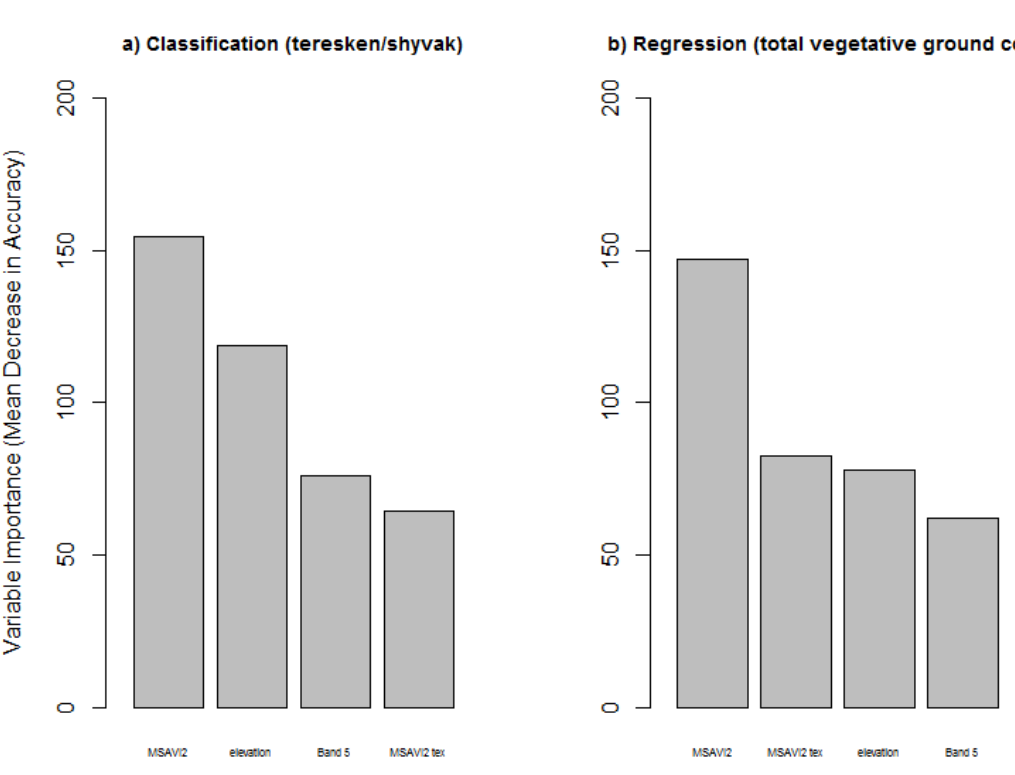
Figure 3. Importance values of the explanatory variables included in the classification ( a ) and regression ( b )